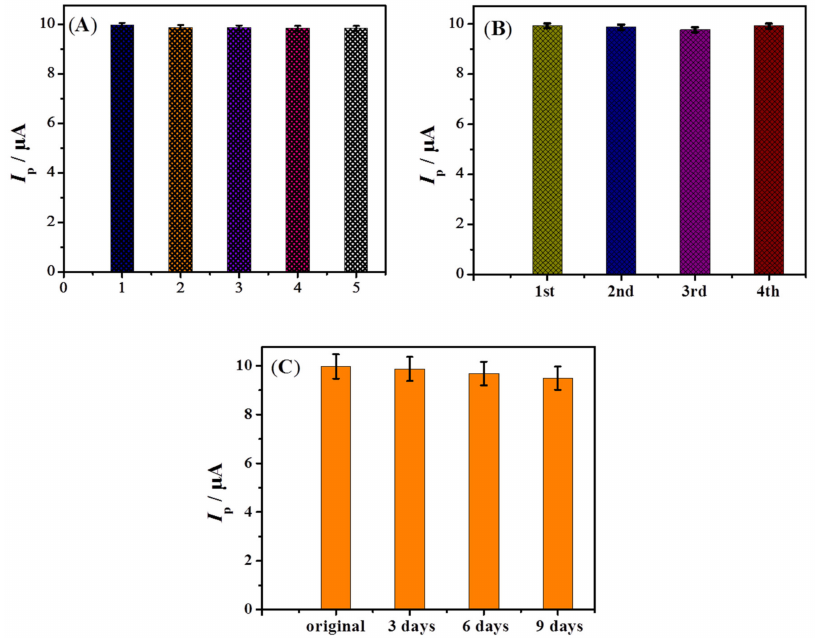
Figure 11. Current response in the context of ( A ) repeatability, ( B ) fabrication reproducibility, and ( C ) stability of the proposed